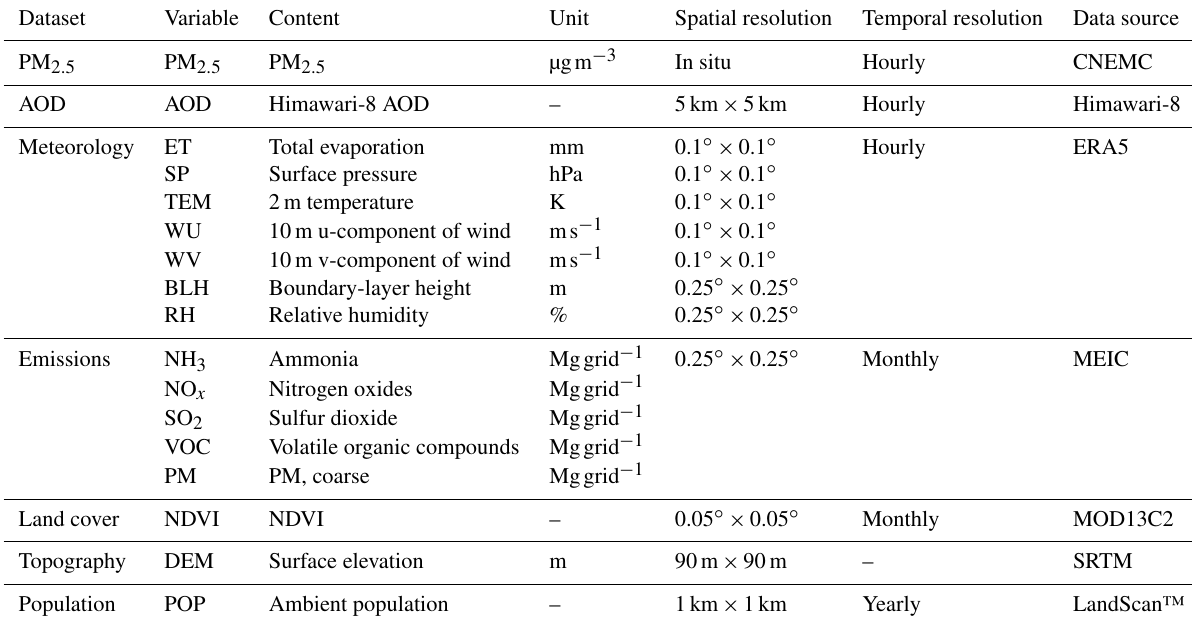
Table 1. Summary of datasets and sources used in this study. CNEMC is the China National Environmental Monitoring Center.